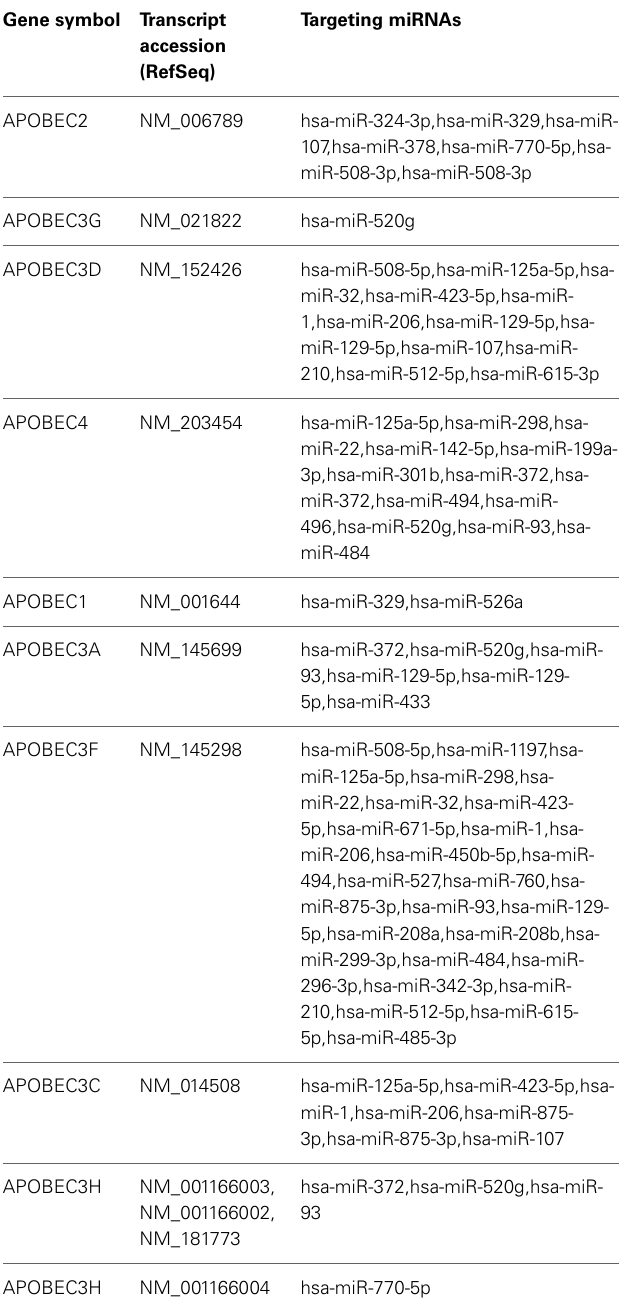
Table 3 | Targets of miRNAs expressed in HIV infected PBMCs on human APOBEC family